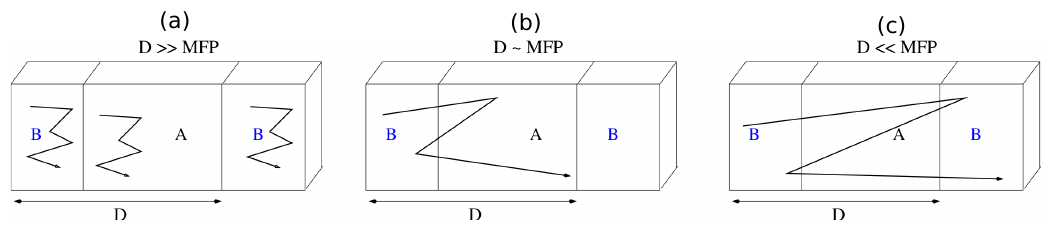
Figure 2. Schematic illustration of relative sizes of repeat period D and phonon mean free path (MFP) Λ for a A/B planar superlattice: ( a ) D >> Λ , ( b ) D ∼ Λ , and ( c ) D << Λ